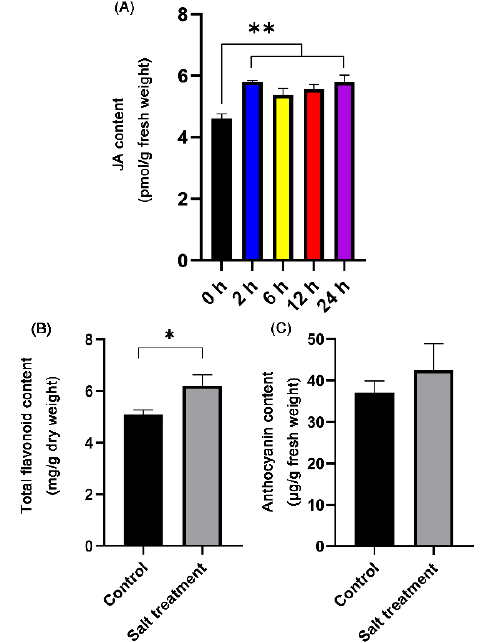
Figure 8. The contents of JA, total flavonoids, and anthocyanidin in leaves under salt stress. ( A ) JA content at different time points under salt stress. ( B ) The contents of total flavonoids in control and salt-stress treatments. ( C ) The contents of anthocyanidin in control and salt-stress treatments. Statistical significance was calculated using Student’s t -tests. * p < 0.05, ** p < 0.01.